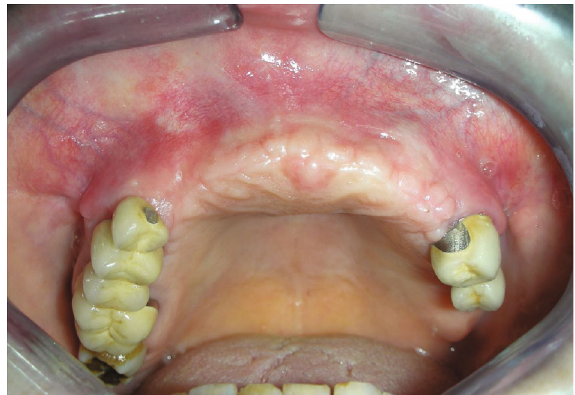
Figure 7: Postoperative complete wound healing observed 2 weeks after surgery.